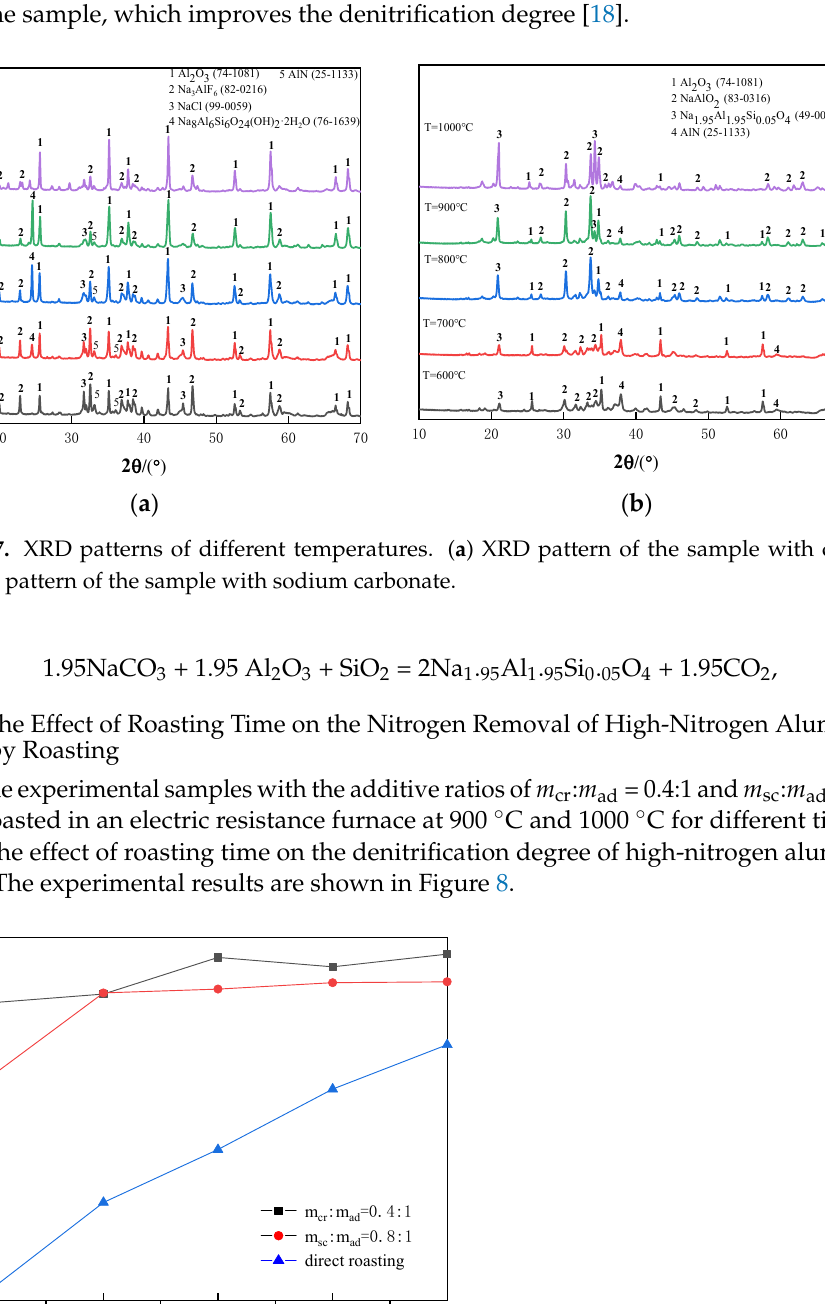
Figure 7. XRD patterns of different temperatures. ( a ) XRD pattern of the sample with cryolite; ( b ) XRD pattern of the sample with sodium carbonate.